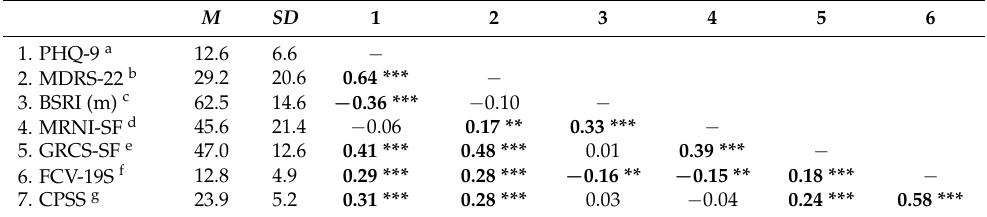
Table 2. Correlation matrix for study